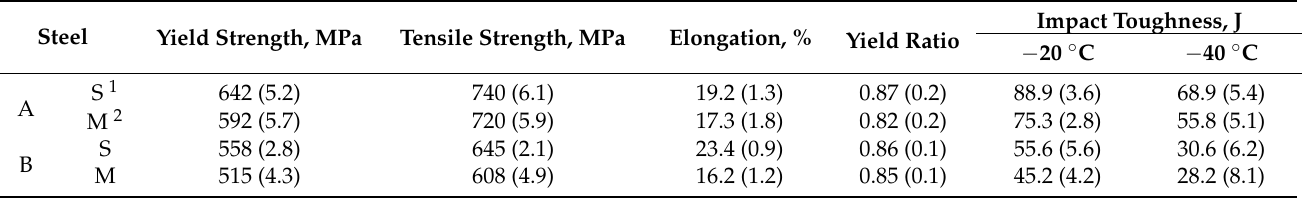
Figure 4. Vickers hardness evolution from the surface to the center part.